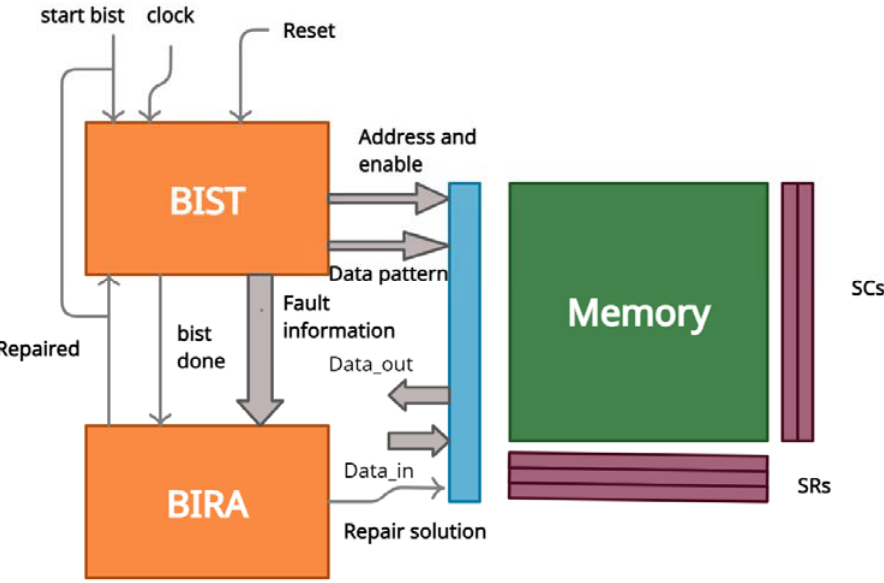
Figure 1. Proposed built-in self-repair (BISR) architecture.